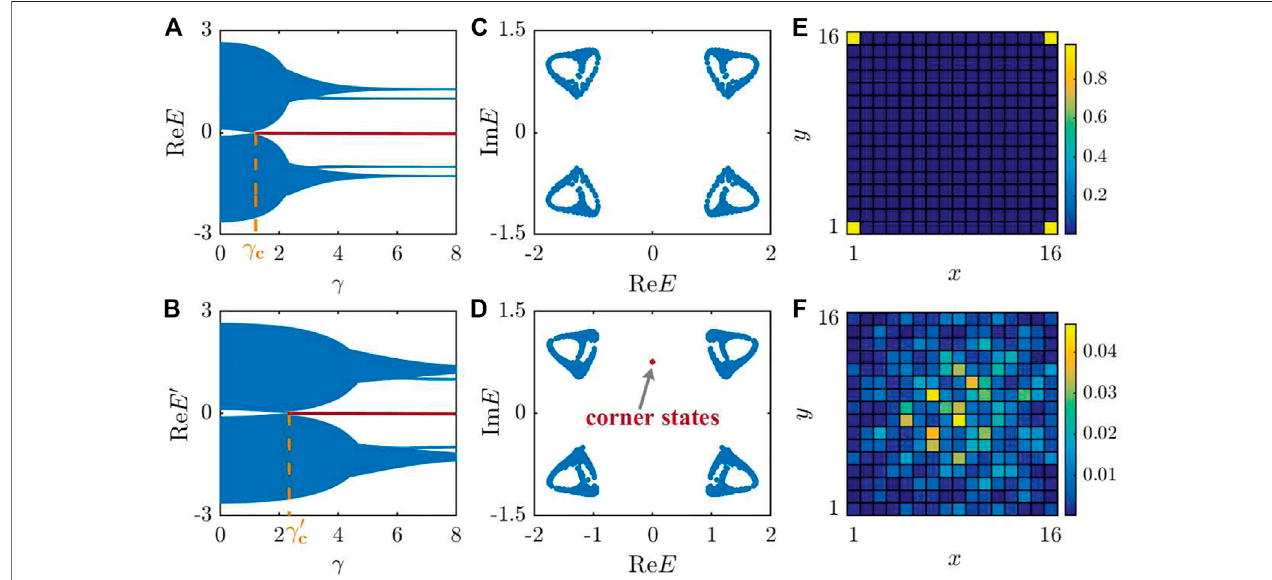
FIGURE 2 | (A,B) Real part of the quasi-energy spectrum obtained from the effective Hamiltonian ^ H eff (cid:1) i ln ^ U step (A) or ^ H eff ′ (cid:1) i ln ^ U step ′ (B) , as a function of γ under the open boundary condition. The bulk energy gap begin to close at γ = γ c ≈ 1.2 (A) or γ (cid:1) γ c ′ ≈ 2 . 4 (B) , where a topological phase transition occurs and in-gap corner states (redline withfourfold degeneracy) emerge when γ > γ c (A) or γ > γ c ′ (B) .The lattice size ischosenas 60,×, 60. (C,D) Typicalquasi-energy spectrum ofthesystem under the periodic boundary condition (C) or the open boundary condition (D) . The gain-loss parameter is γ = 2.5 and the lattice size is same with (A,B) . (E,F) Collectivedensitydistributions Σ i | Ψ R i ( x , y )| 2 ofthefour-degeneratecornerstateswithstatenumbers{127,128,129,130} (E) andtwo-degeneratebulkstateswithstate numbers{161,162} (F) .Theeigenstatesaresortedbythevalueoftherealpartofthequasi-energy.Thegain-lossparameterischosenas γ =3.5andthelatticesizeis16 × 16. Here the coupling parameter is fi xed at J 1 / J 2 =